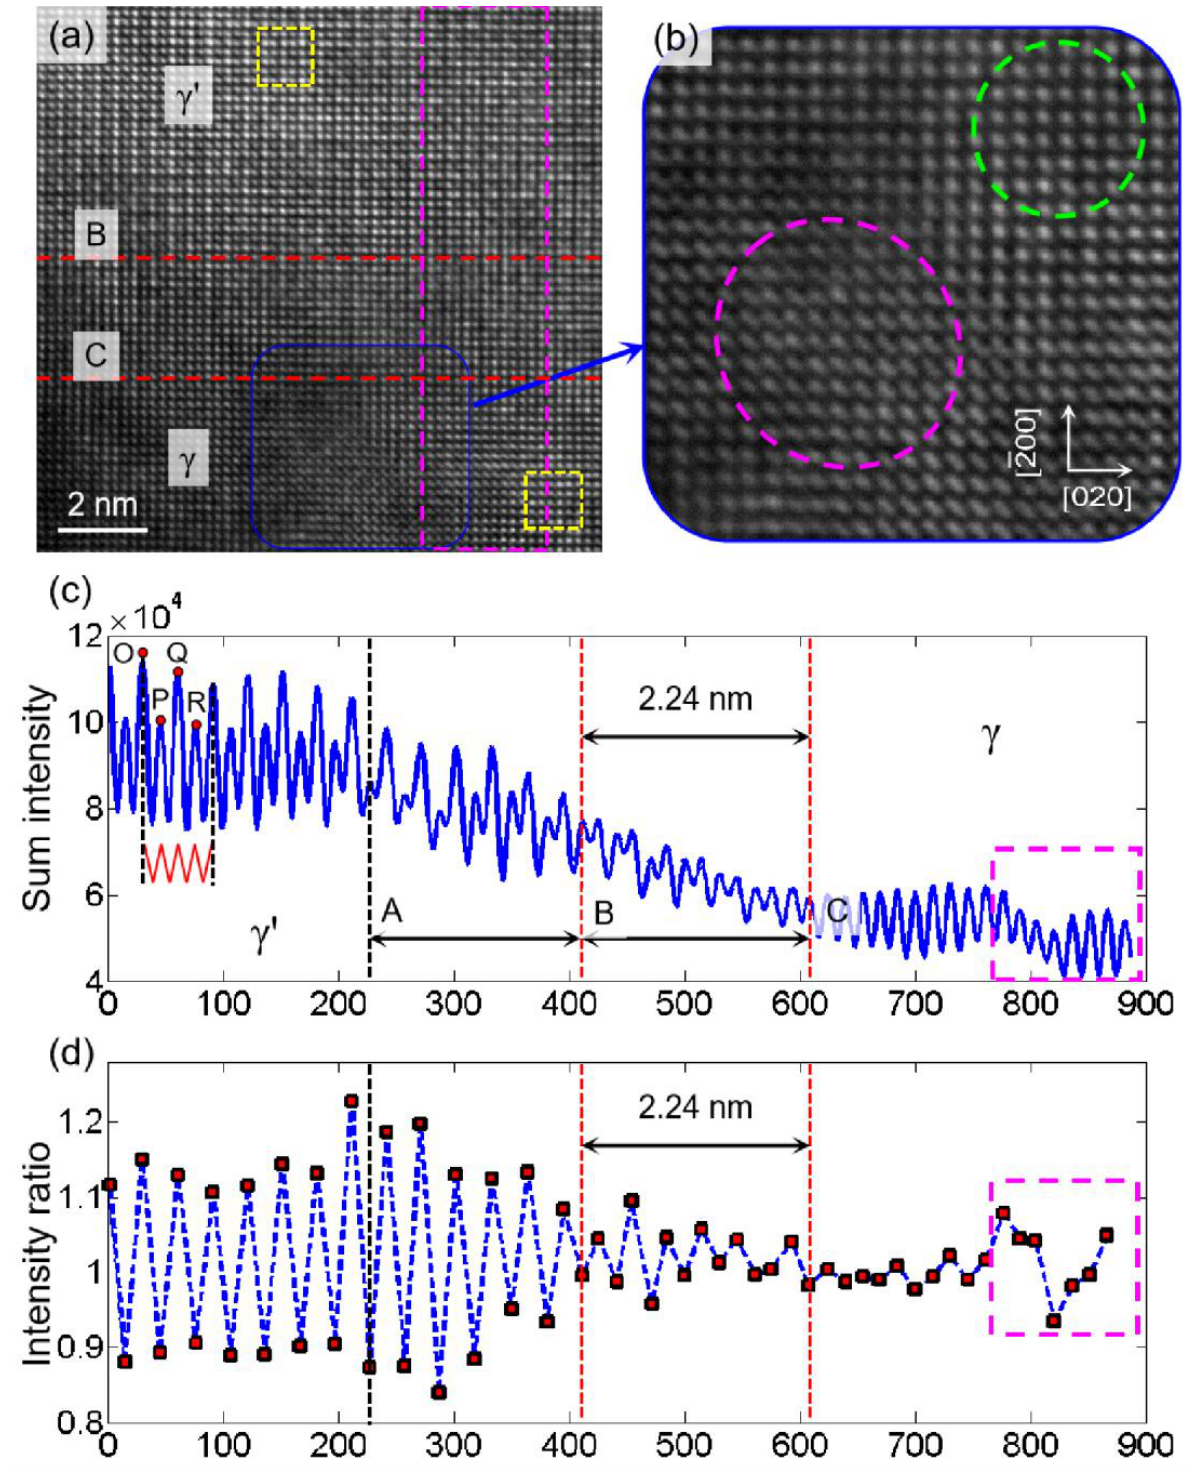
Figure 5. Intensity ratio analysis. ( a , b ) Filtered HRTEM image at the two-phase interface; ( c ) Sum intensity profiles across the [020] direction of the pink dashed box showing the transition from ordered γ’ to disordered γ; and ( d ) Intensity ratio of each atomic column to its adjacent column on the right.